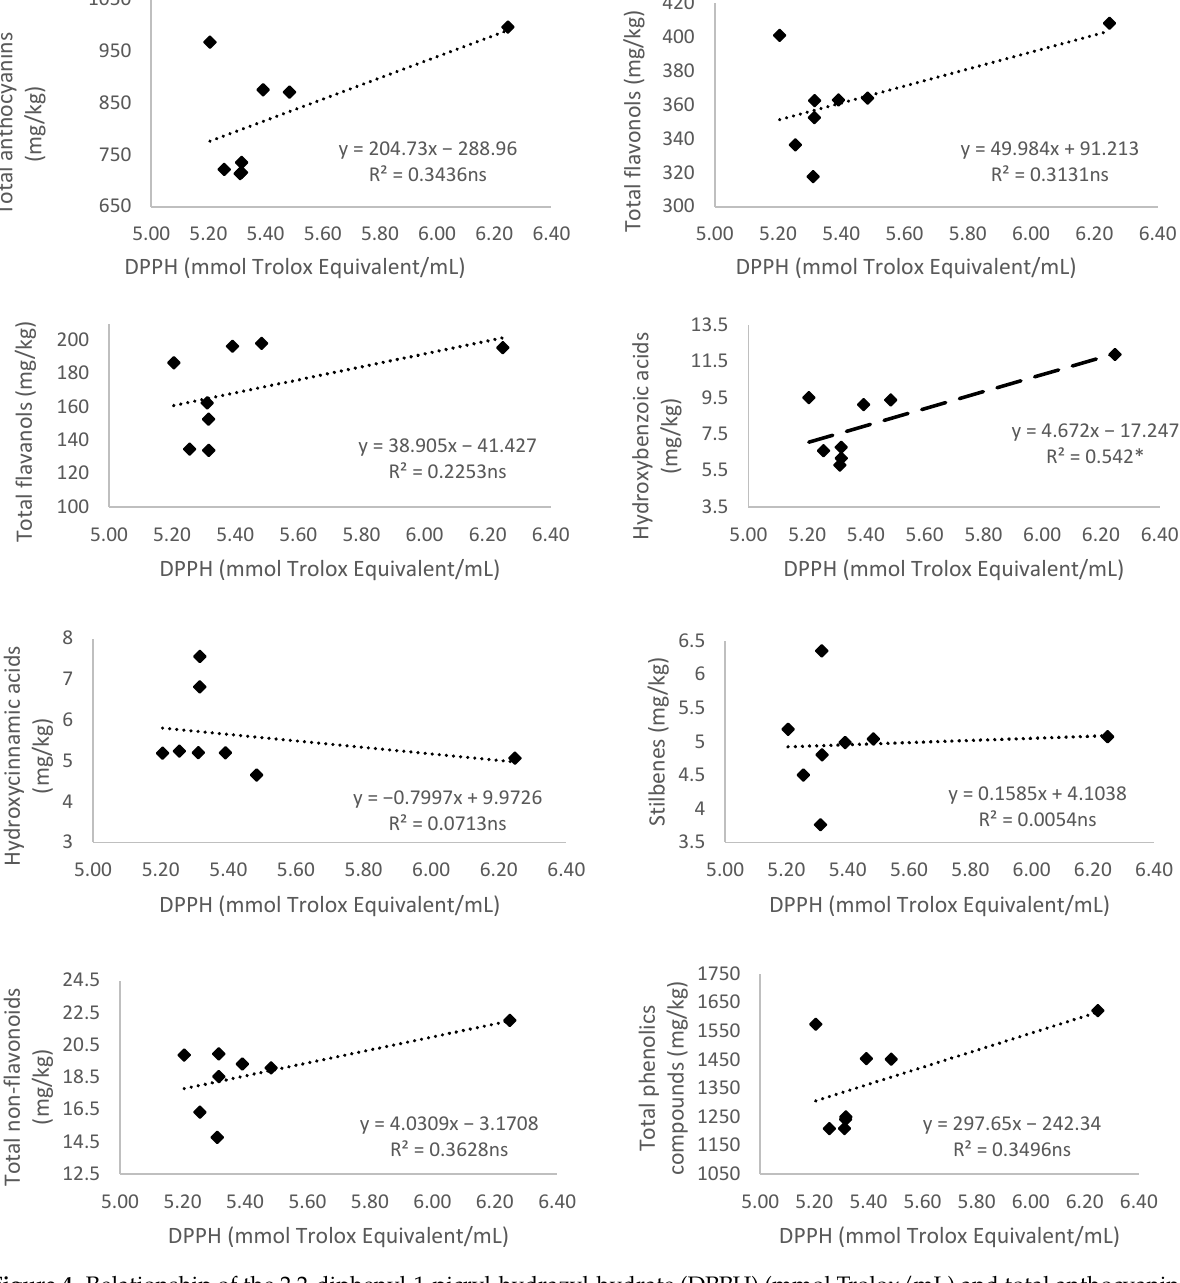
Figure 4. Relationship of the 2,2-diphenyl-1-picryl-hydrazyl-hydrate (DPPH) (mmol Trolox/mL) and total anthocyanins, flavonols, flavanols, hydroxybenzoic and hydroxycinnamic acids, stilbenes, non-flavonoids, and content of total phenolic compounds (mg/kg) of Monastrell grapes. Values of the coefficient of determination (R 2 ) are presented. Lines of linear regression are shown: (- - -) when relationships are significant ( p < 0.05, *), or ( · · · ) when there are no significant differences ( p > 0.05, ns).